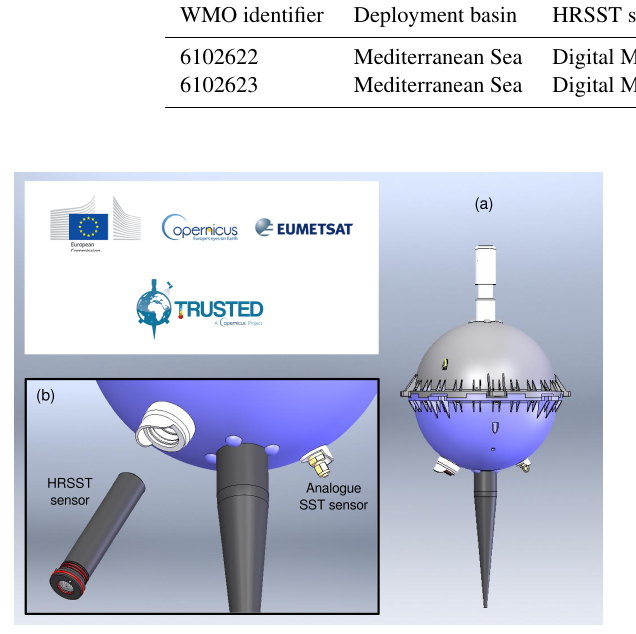
Figure 6. Sketch of the SVP-BRST (for the drogue, only the tether attachment is shown here), with the HRSST sensor unplugged shown in zoom panel (b) . Note each SST sensor is protected from solar radiation by a